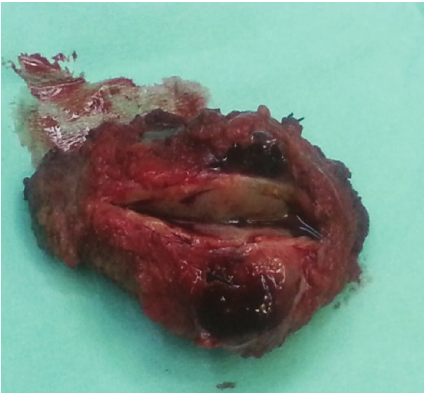
Figure 2: Macroscopic appearance of the metastases from bladder cancer to left sartorius muscle.